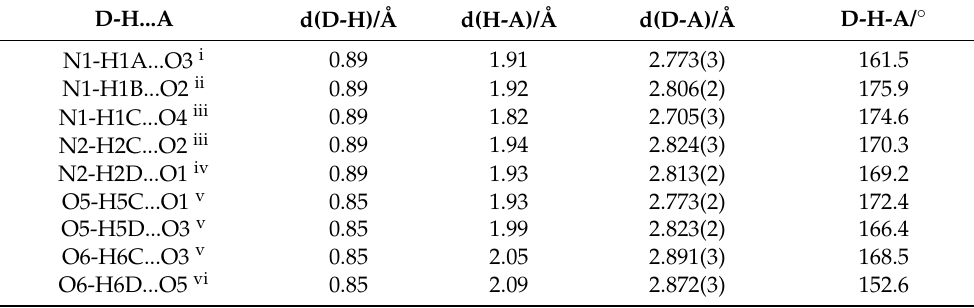
Table 5. Hydrogen bonds for